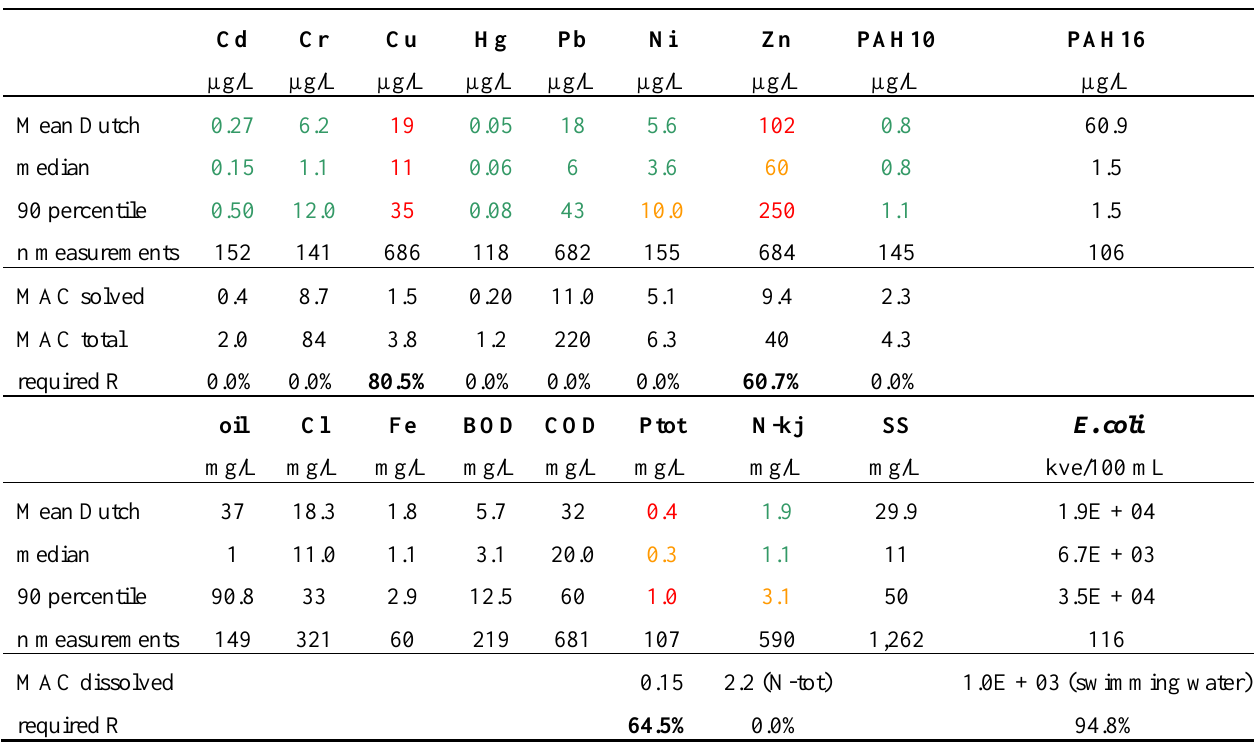
Table 2. Concentrations of pollutants in stormwater runoff from Dutch residential areas roofs and